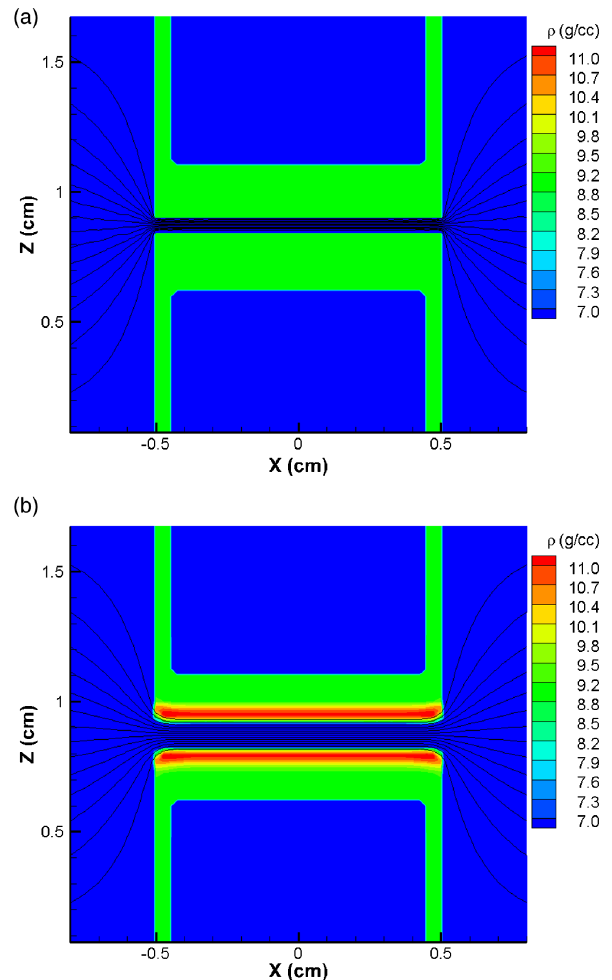
FIG. 14. Contour plots of density in ICE panels at (a) 0 and (b) 300 ns (peak pressure). Lines are magnetic